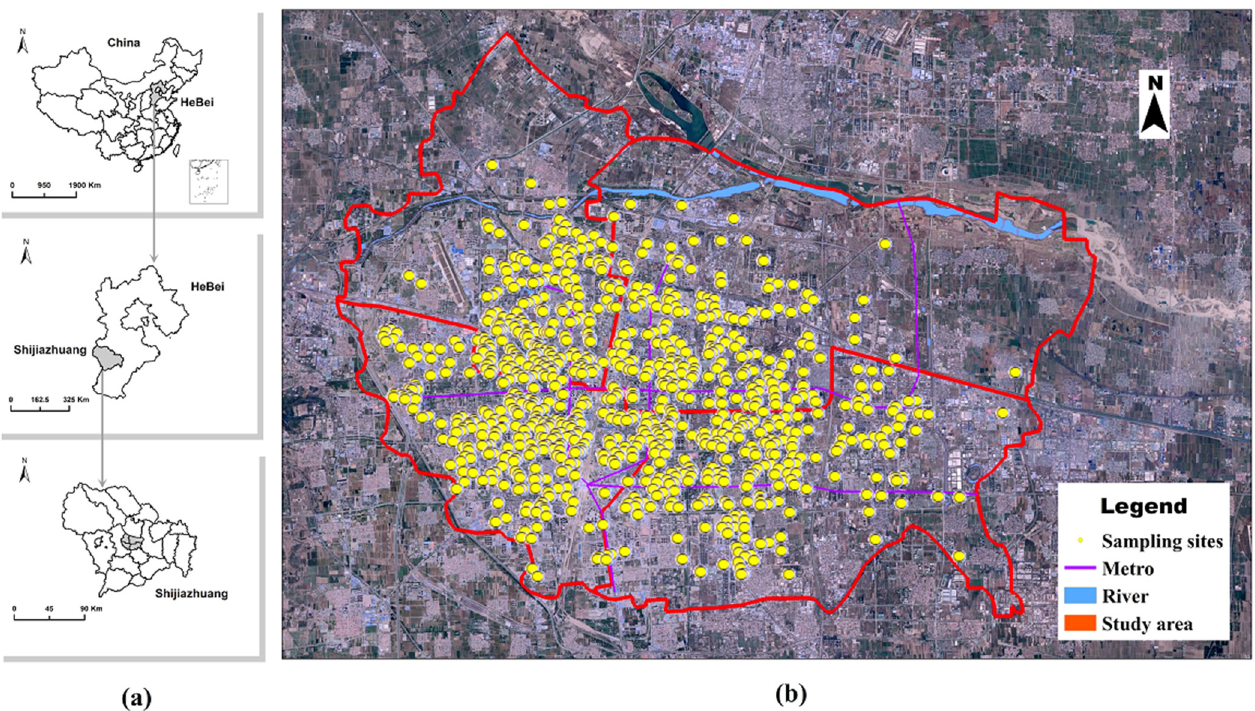
Figure 1. Map of the study area in SJZ city: ( a ) Geographical locations at national, provincial, and city scales; ( b ) Google Earth images, in 2021, at local scales.